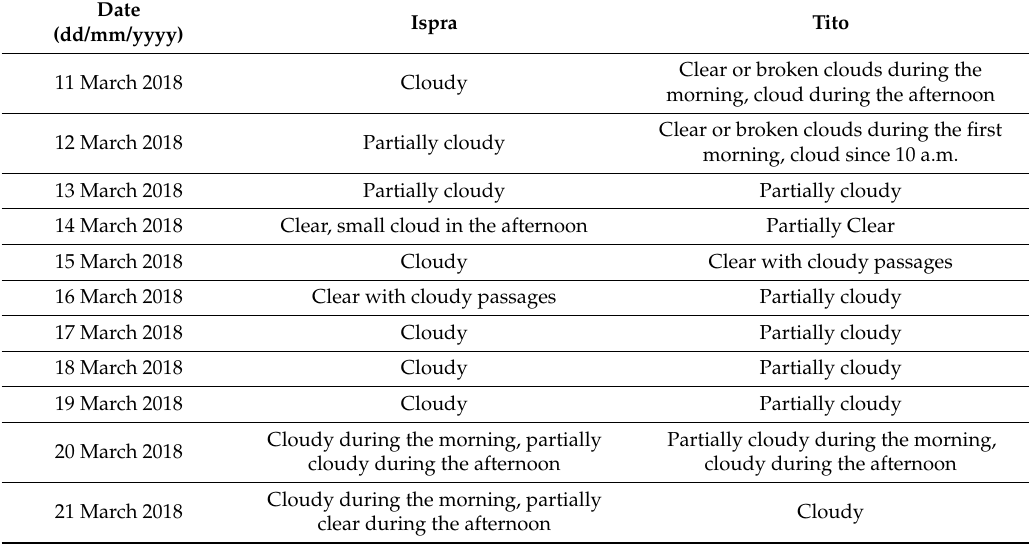
Table 1. Qualitative description of the dataset weather